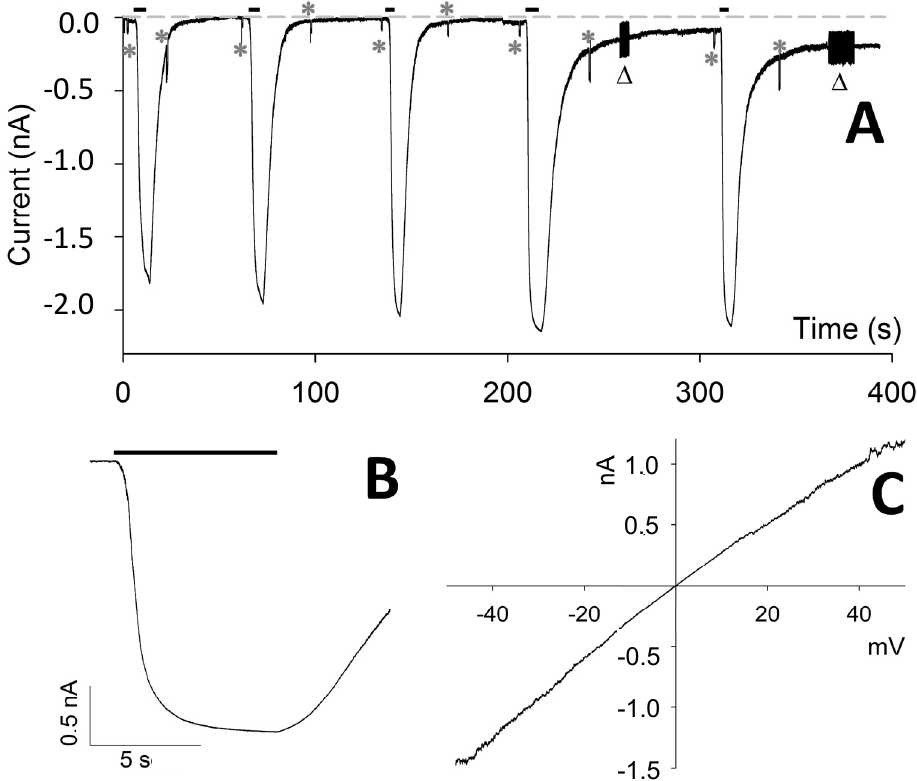
Figure 3. Repeated applications of CM on CHO-K1 cells. ( A ) Whole-cell current 18 recording elicited by five consecutive applications and withdrawals of 4 µM of CM lasting, in sequence, 6.1, 5.2, 4.7, 6.2, and 4.1 s; the parameters characterizing the current following each one of the five peptide applications were respectively: delay : 1.7, 1.0, 0.9, 0.9, 0.9 s; τ : 1.5, 1.2, 0.8, 0.7, 0.7 s; current amplitude: 1.8, 1.9, 2.0, 2.1, 2.0 nA; τ a